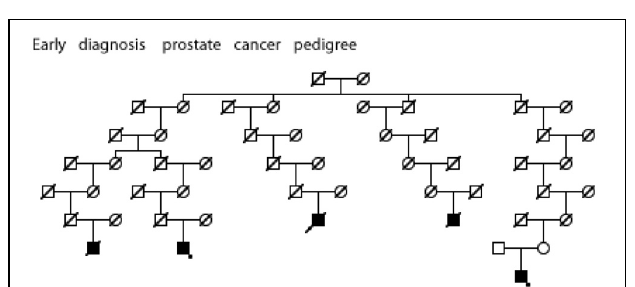
FIGURE 6 | High risk Utah prostate cancer pedigree (173 prostate cancers observed among descendants of the pedigree founder, 131 expected, p = 0 . 0003); cases diagnosed before age 50 years are shown. The two cases with an asterisk were also observed to have BMI ≥ 30 (data not available for all cases).